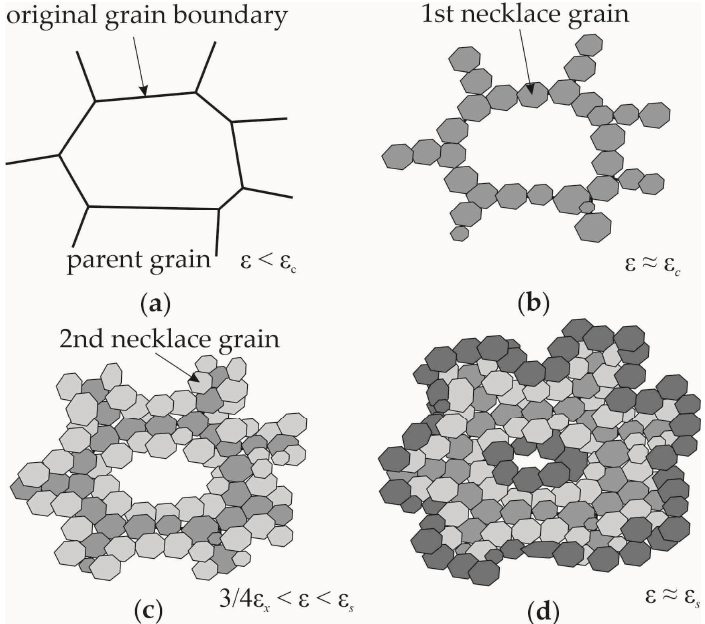
Figure 1. Scheme for the formation of a fine-grained structure during DDRX at various degrees of deformation ε : ε < ε c ( a ), ε ≈ ε c ( b ), 3/4 ε x < ε < ε s ( c ), ε ≈ ε s ( d ) (it was developed based on